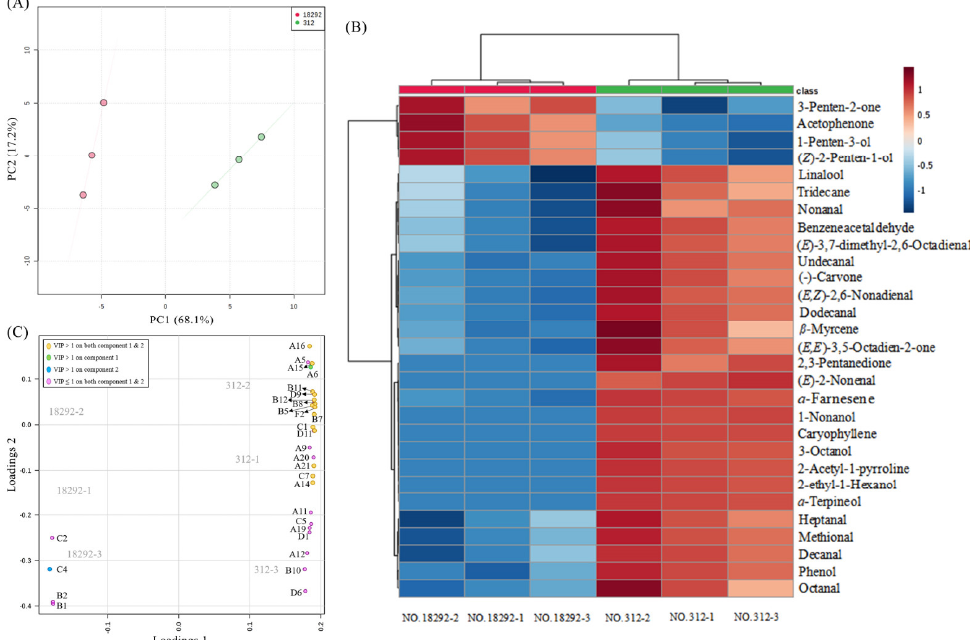
Figure 1. Chemometric analyses. ( A ) PCA scatter plots of the first two principal components using all the identified volatiles from pumpkin sample No. 312 with ‘taro-like’ aroma and sample No. 18292 without ‘taro-like’ aroma. ( B ) The heat map and feature-wise HCA dendrogram of the significantly-varied volatiles in two samples. Each sample was tested in triplicate. Red indicating high content, and blue representing low content. ( C ) Compounds with VIP score are highlighted by different colors using PLS-DA based on the differential volatiles between the samples No. 312 and No. 18292.